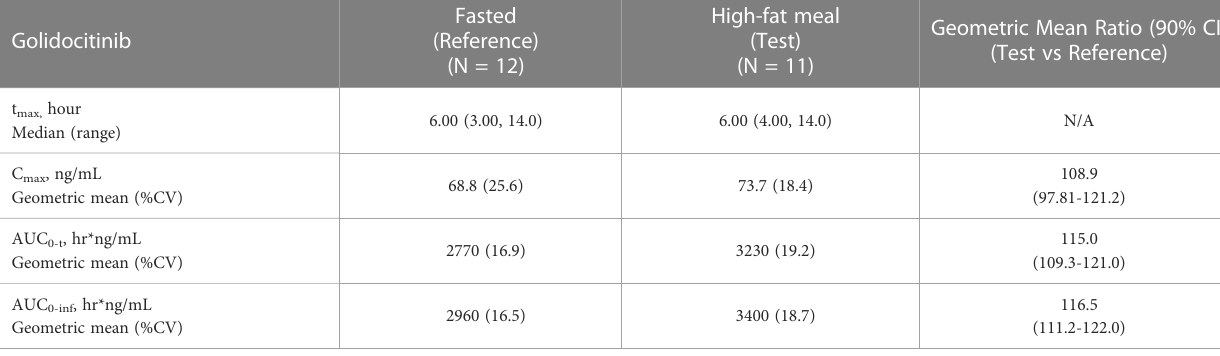
TABLE 3 Statistical analysis of the effect of food on the PK parameters of golidocitinib.